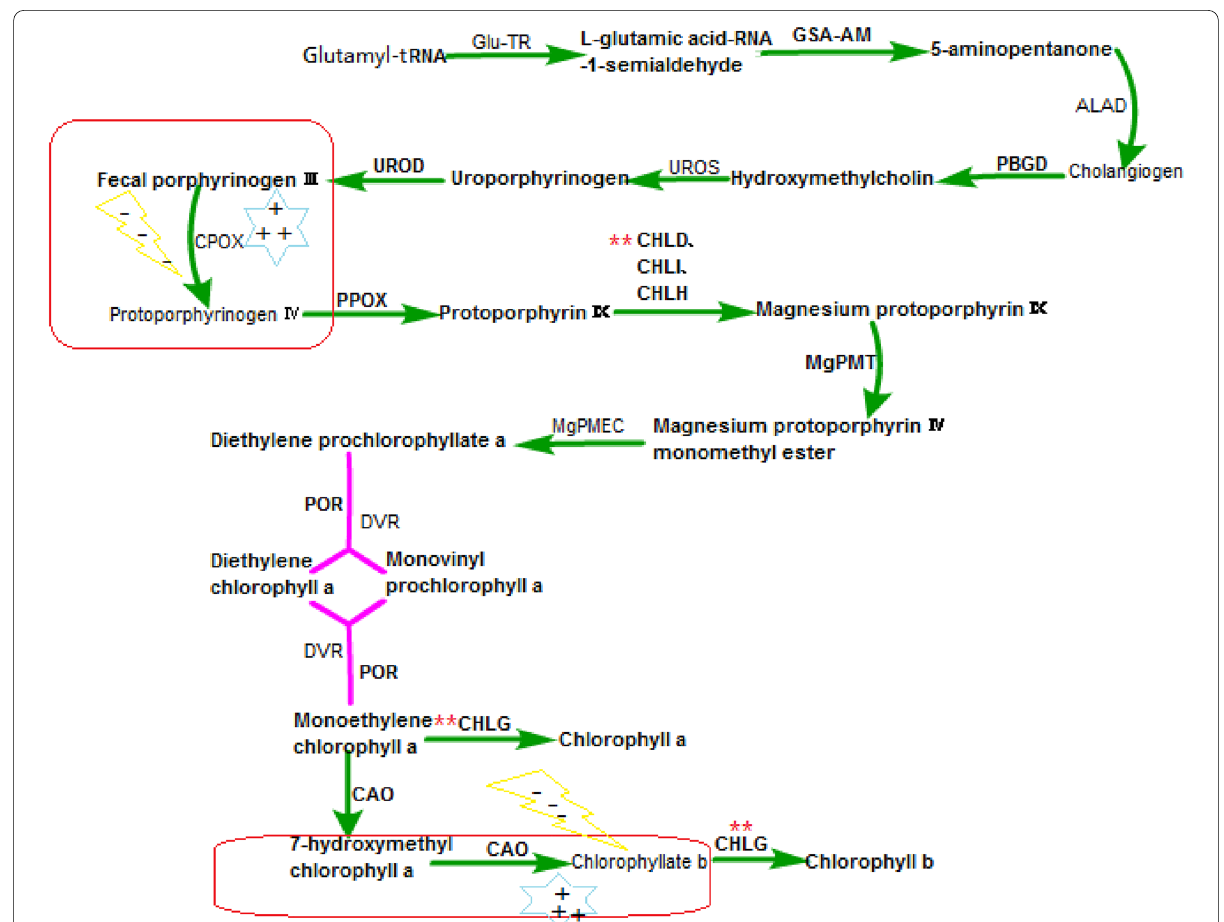
Fig. 1 Synthesis pathway of chlorophyll (“**”: key enzymes or genes regulating chlorophyll synthesis; the red line frame is the blocking point of chlorophyll synthesis in etiolated tea that is exposed strong light. The related enzymes and related genes are shown in Table